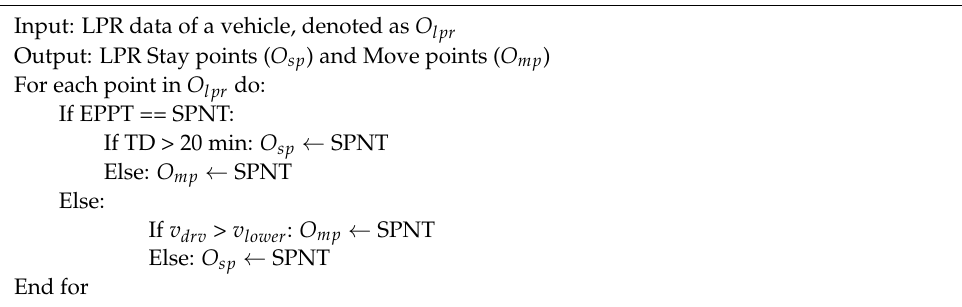
Algorithm 1 Stay point recognition algorithm based on different speed